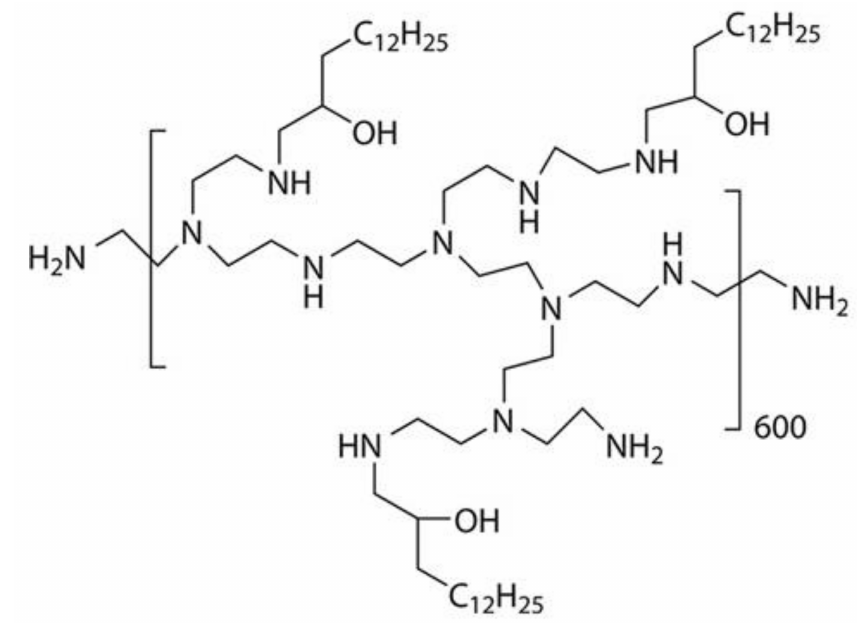
Figure 3. Chemical structure of a 7C1 repeat